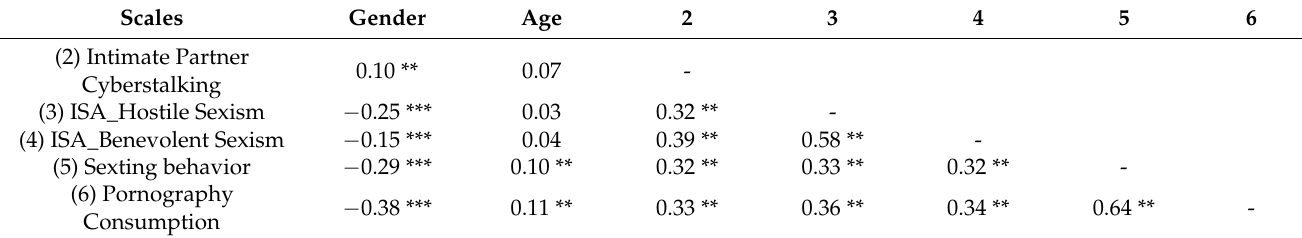
Table 2. Pearson correlations between the various